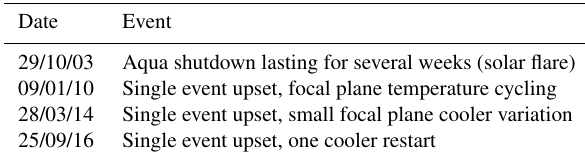
Table 1. Summary of AIRS events that had a thermal impact on either the spectrometer, the focal plane, or both. Dates are in DD/MM/YY